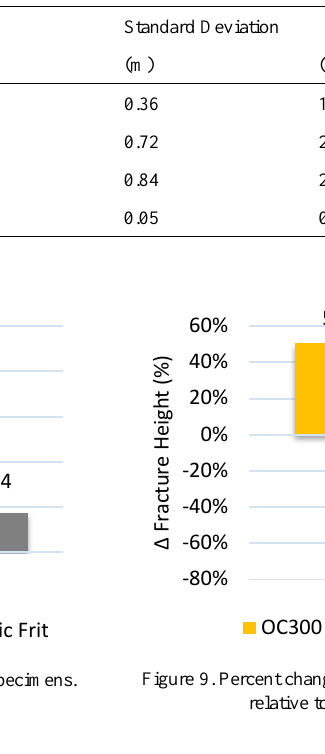
Table 5. Sample statistics displaying mean fracture height, standard deviation, and coefficient of variation (CoV) of all samples.